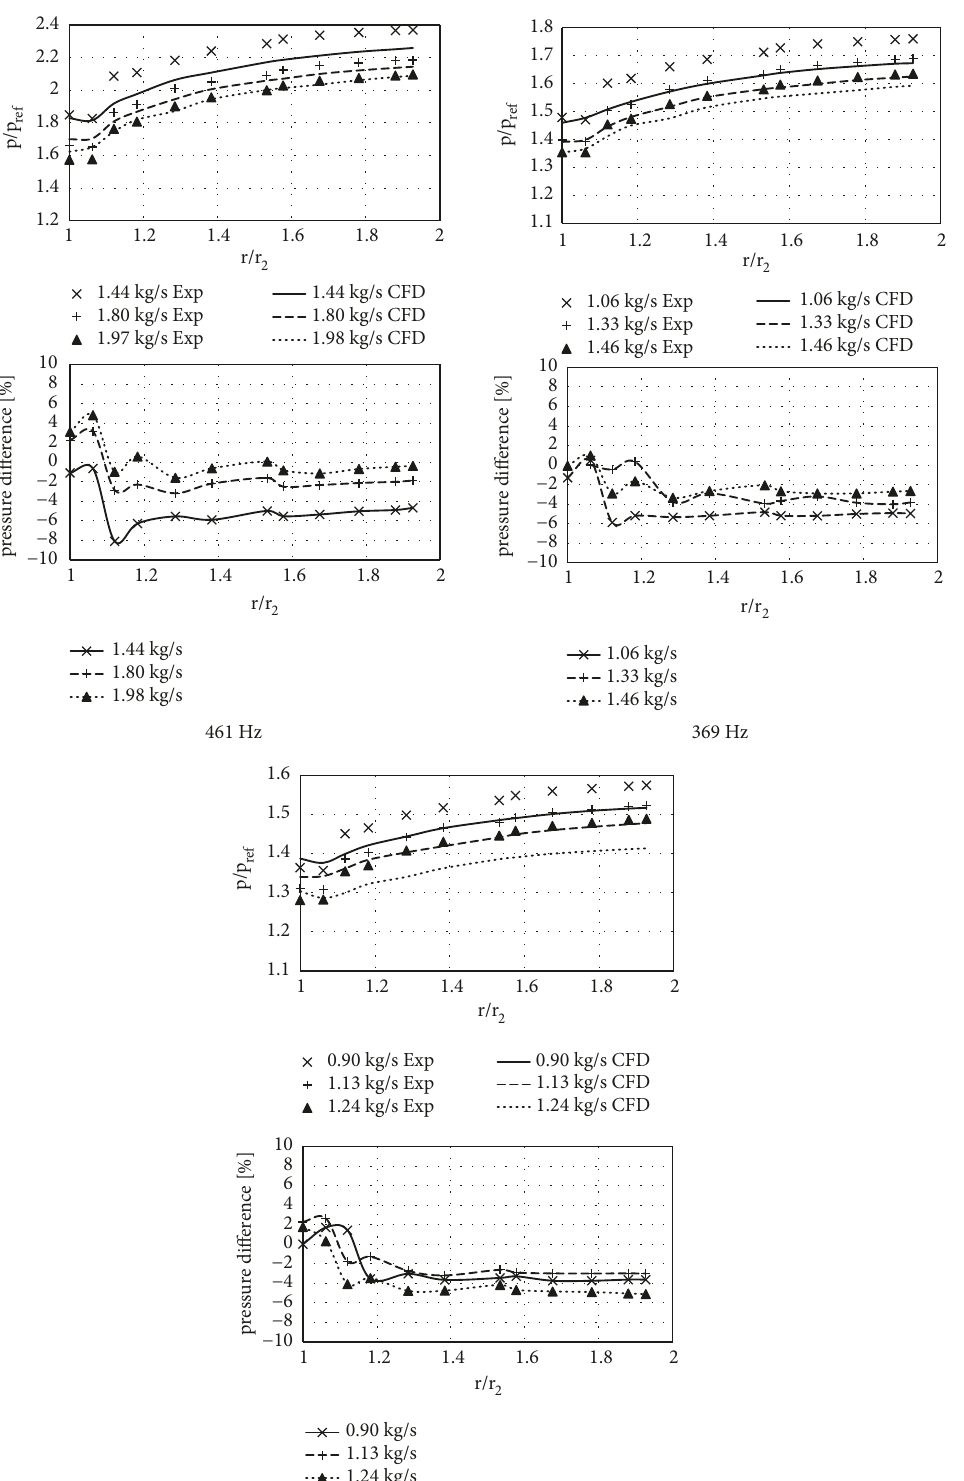
Figure 8: Comparison of experimental and simulated pressure